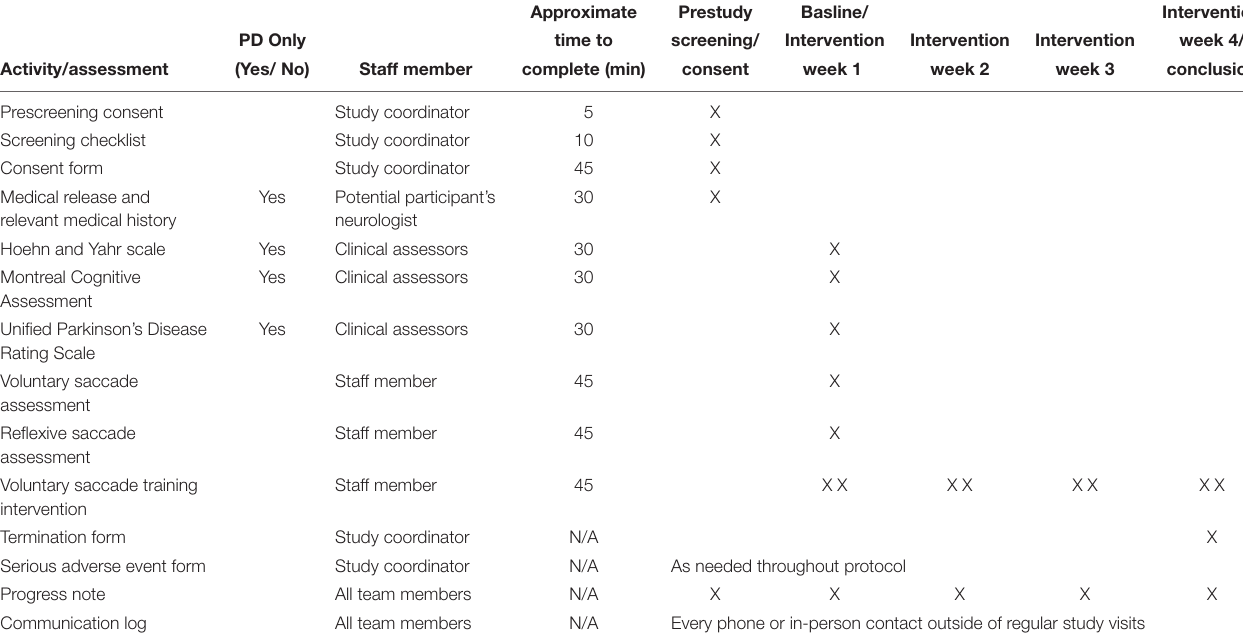
TABLE 5 | Investigator team activity